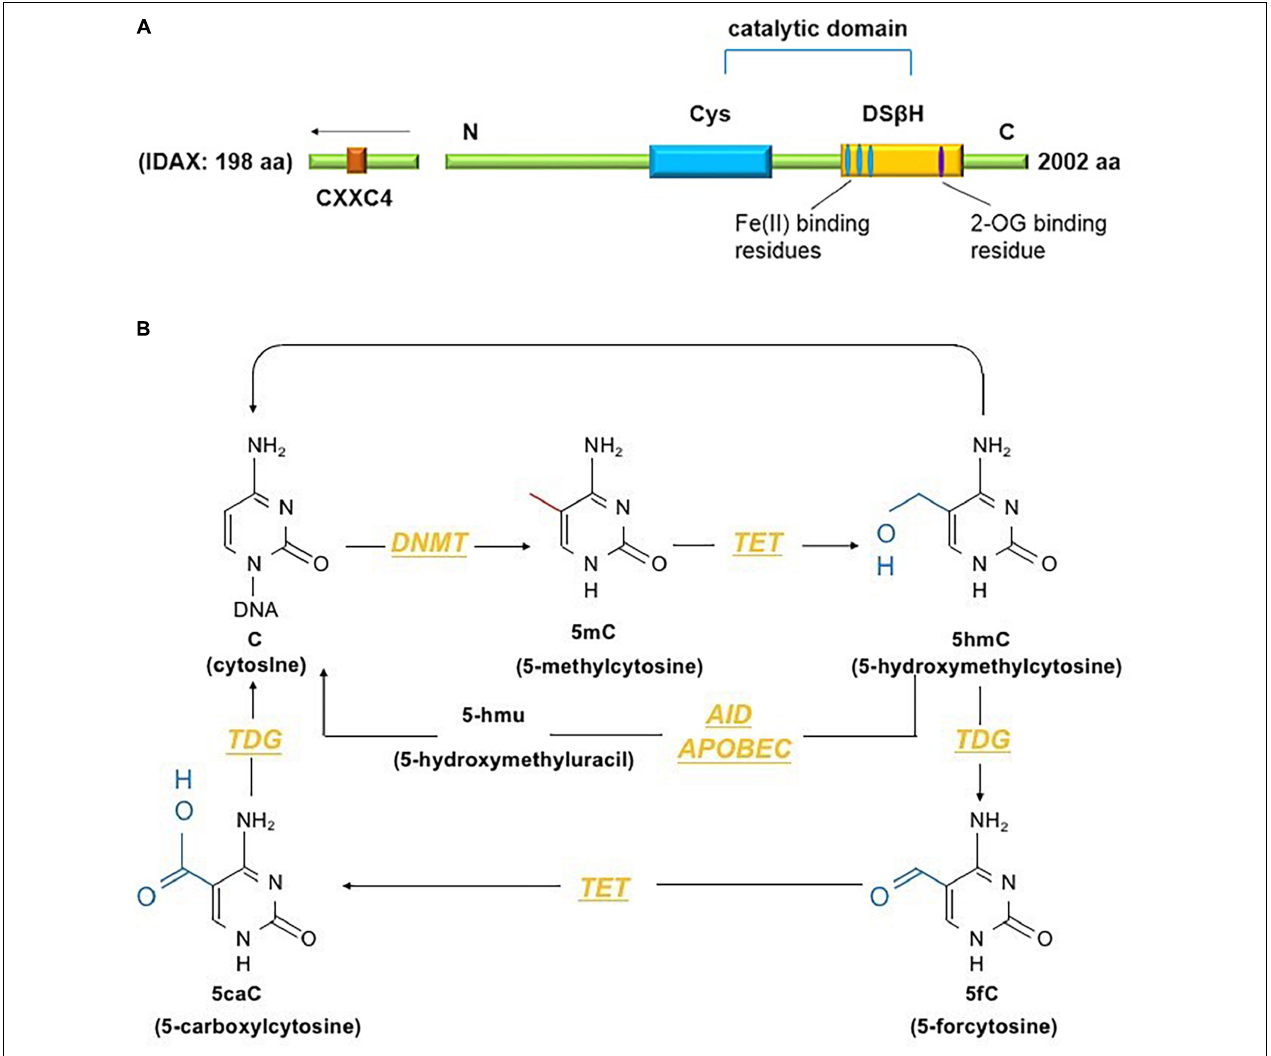
FIGURE 1 | (A) The conserved structural domains of Tet2 proteins include a cysteine (Cys)-rich domain and a double-stranded β -helix fold (DS β H), which is characteristic of Fe(II) and 2-oxoglutarate binding and is required for the catalytic activity of Tet2 (Feng et al., 2019). Additionally, the CXXC domain of Tet2 is encoded by the independent IDAX gene, which is also called CXXC4 (Li and Xu, 2019). (B) DNA methyltransferases (DNMTs) methylate unmodified cytosine (C) residues at the 5 position to form 5mC. The Tet proteins then convert 5mC to 5hmC, 5fC, and 5caC (considered active modifications), and 5hmC can be deaminated to form 5hmU via the AID- and APOBEC-mediated pathways (Solary et al.,